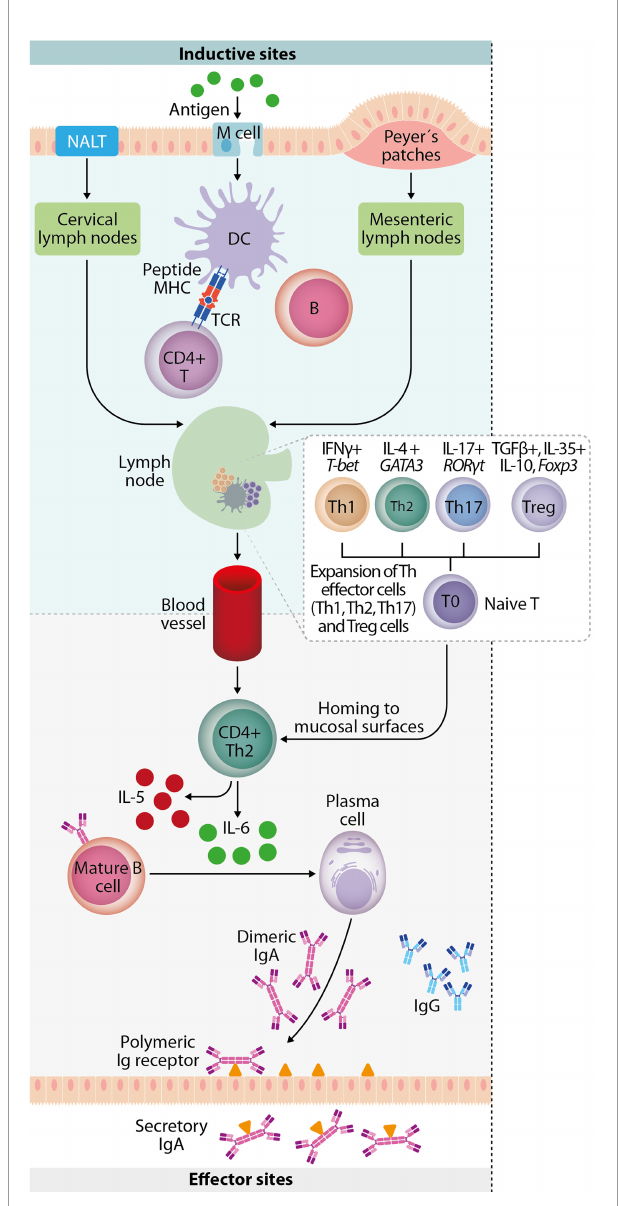
FIGURE 3 | Mucosal immune response. Mucosal immunity plays a crucial role against invading pathogens on the epithelial cell surface, involving a complex network of innate and adaptive immune components. Luminal antigens are transported to the nasopharynx-associated lymphoid tissue (NALT) and gut-associated lymphoid tissue (GALT) through M cells in the epithelium overlying NALT and Peyer ’ s patches. Mucosal dendritic cells